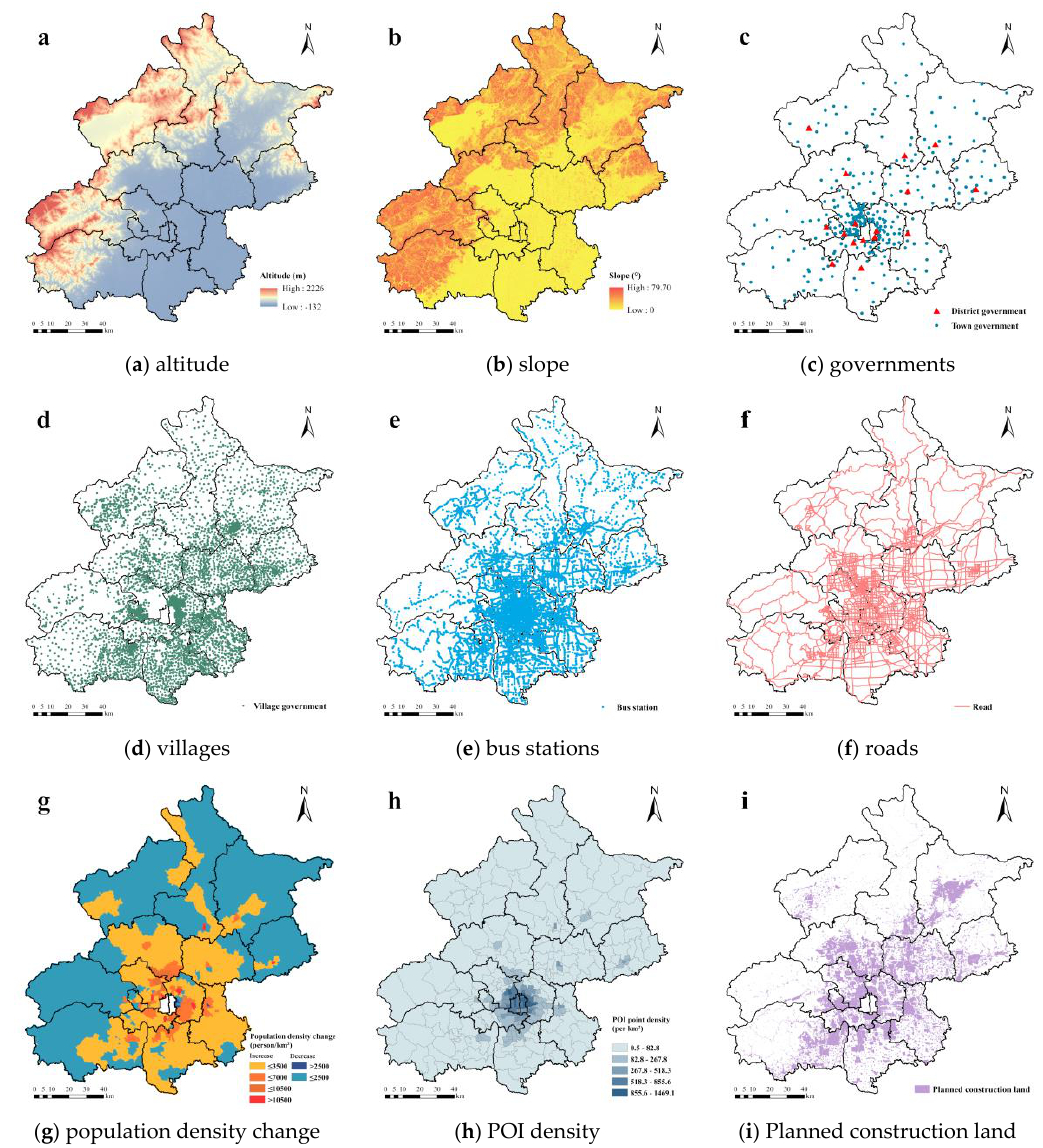
Figure 2. Distribution map of independent variables.